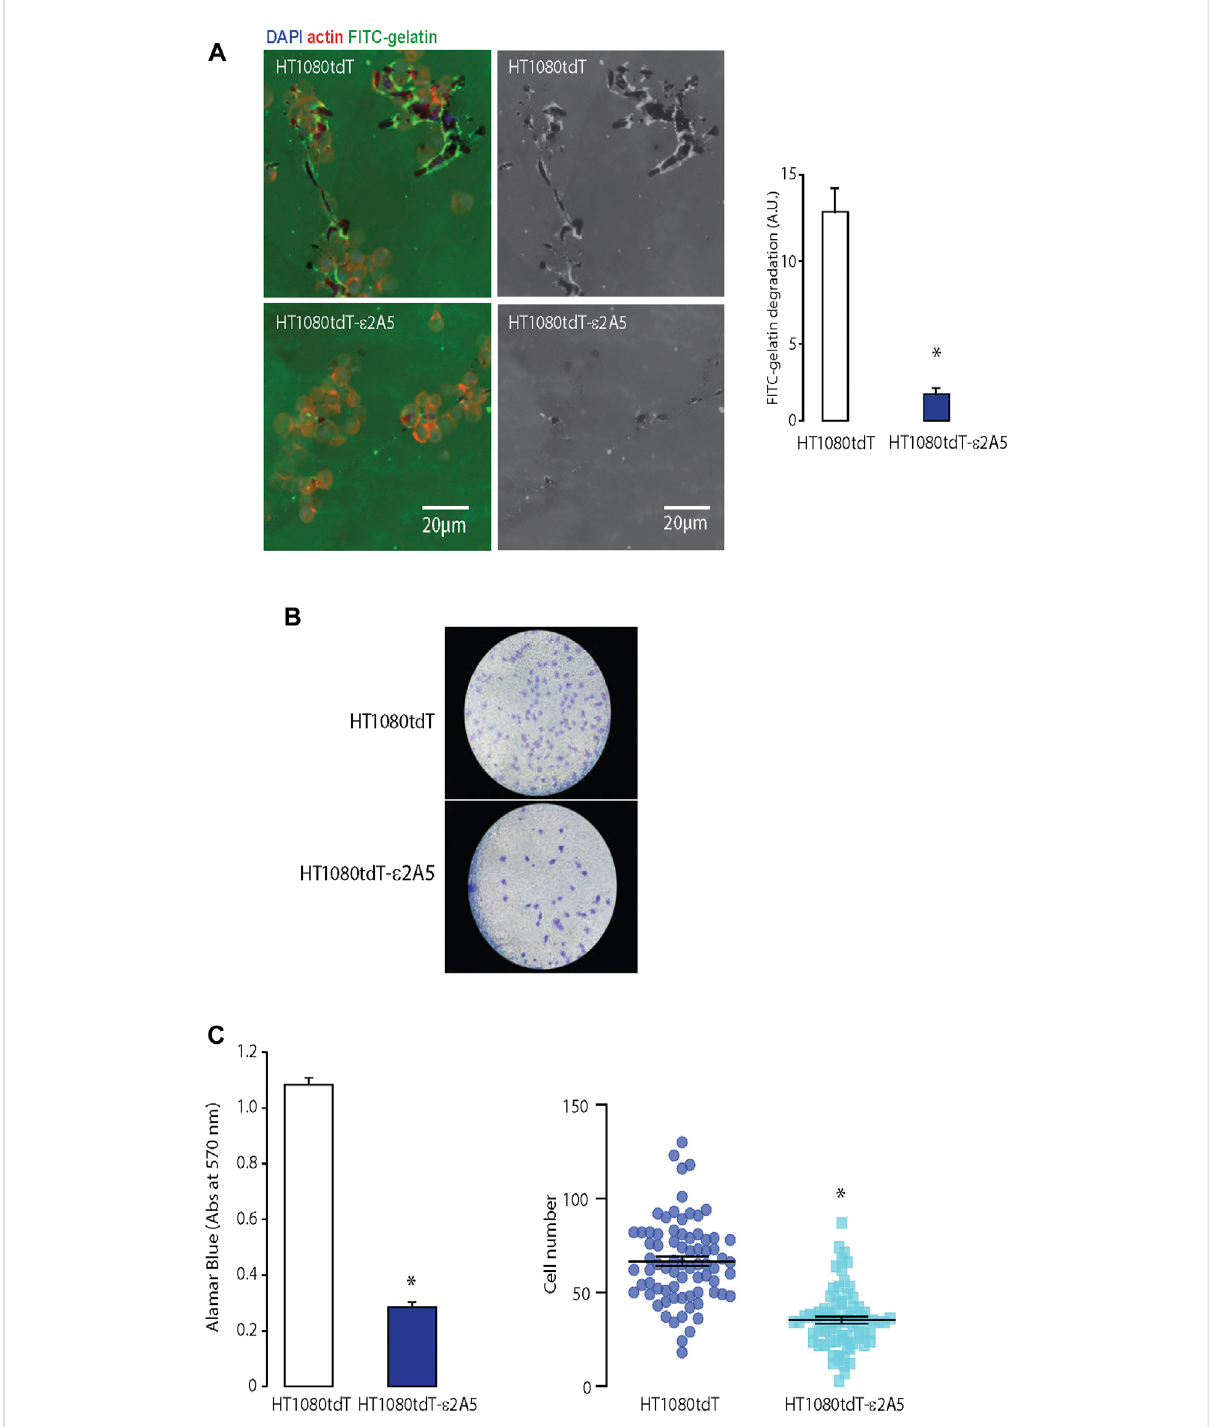
FIGURE 4 Migration of the HT1080tdT- ε 2A5 fi brosarcoma cells. (A) . An FITC-gelatin degradation assay for invasiveness of HT1080tdT and HT1080tdT- ε 2A5cells.Sampleswereco-stainedwithDAPIandactin.* p < 0.0001,n=3. (B) .TranswellmigrationofHT1080tdTandHT1080tdT- ε 2A5.Cellswere fi xed in 100% methanol and stained with Coomassie blue (n = 3). (C) . Transmigration of HT1080tdT and HT1080tdT- ε 2A5 across an 8 µm pore membrane. * p < 0.0001, n = 3. The images are representative of more than 3 biological replicates.